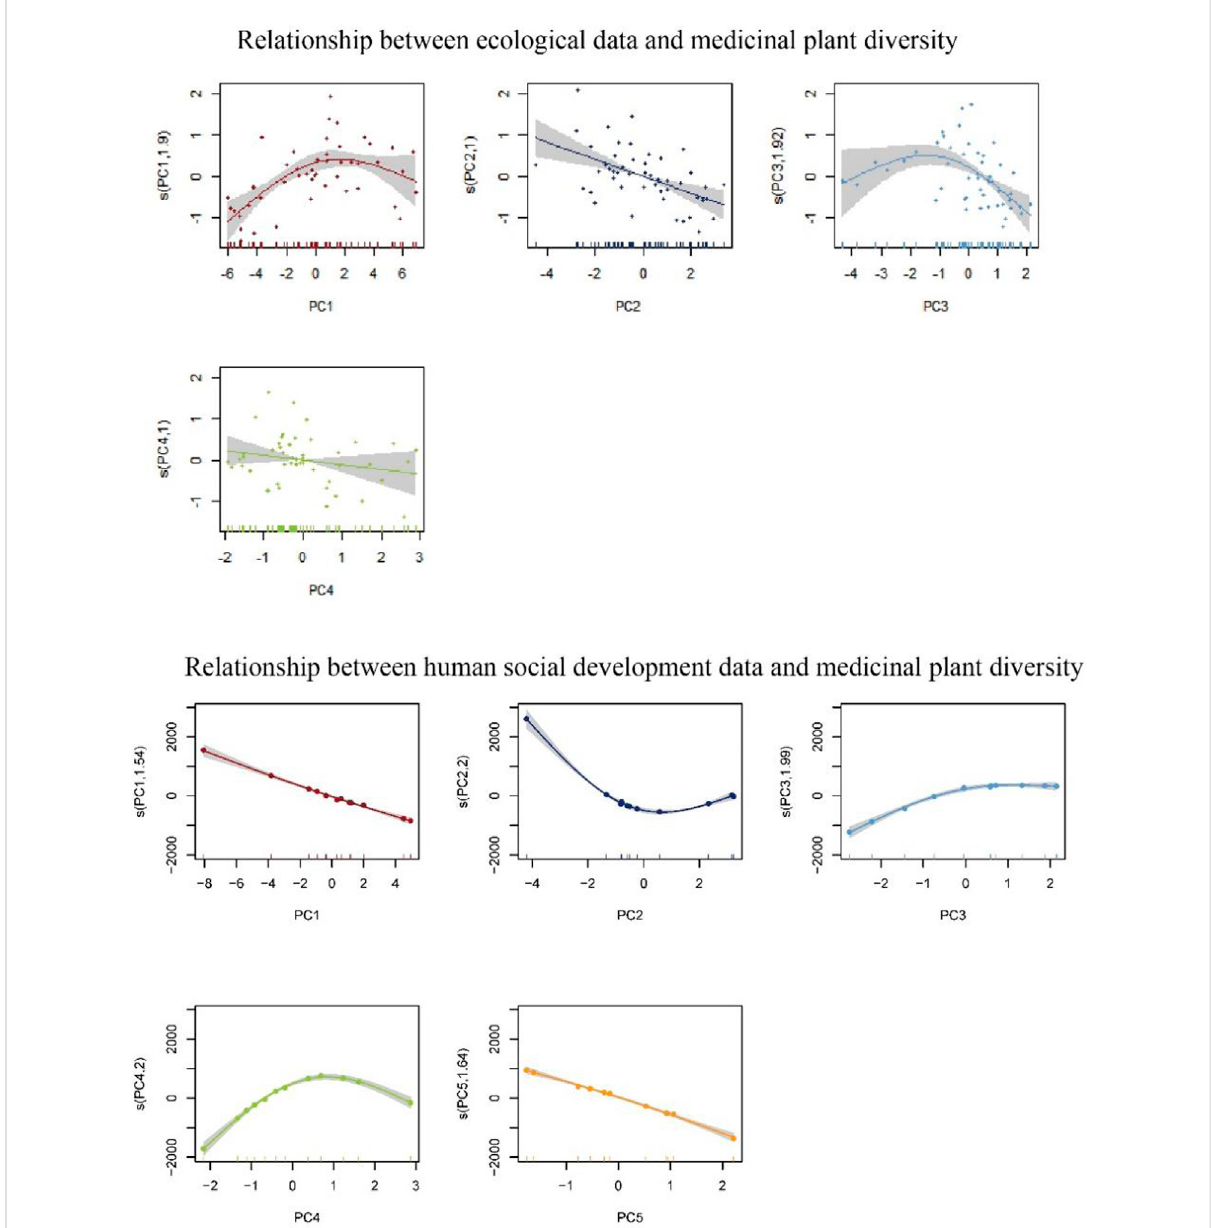
FIGURE 6 Relationship between each variable and medicinal plants diversity after principal component